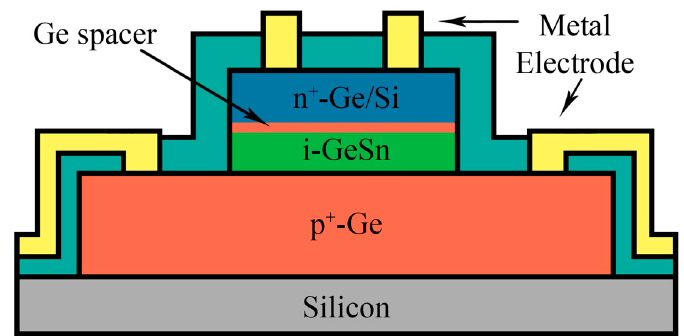
Figure 2. Schematic cross-section of the GeSn on Ge p-i-n photodiode structure. The 1550 nm photodiode was investigated and the electrical and optical characteris- tics were measured under certain conditions. The dark current density of the photodiode increased by more than one order of magnitude, which was due to the high Sn concen- tration in this sample. The optical responsivity of the photodetector was also studied, which had shown the excellent quality of the fabricated GeSn layers.